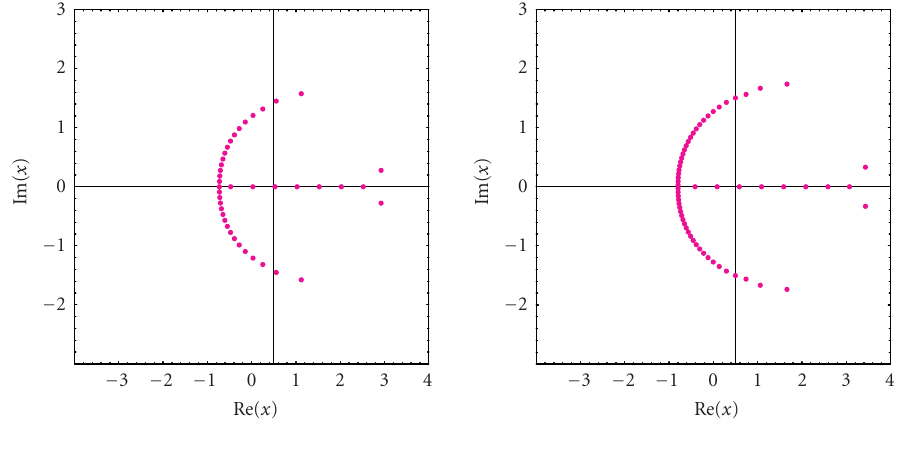
Figure 3.2. Zeros of q -Bernoulli polynomials β m ( x ,1 | 1 / 2), m = 40,60, and x ∈ C .